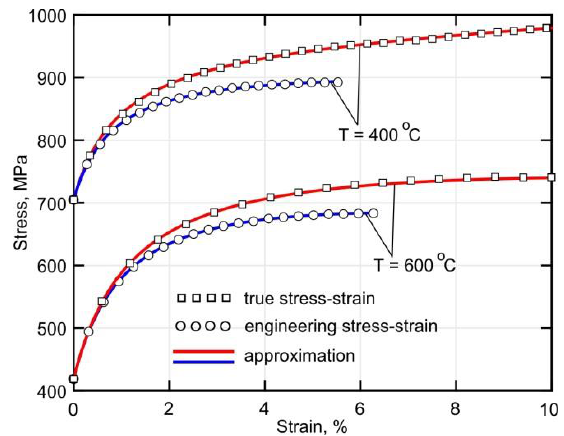
Figure 4. An example of the measured stress–strain curves and their approximation.